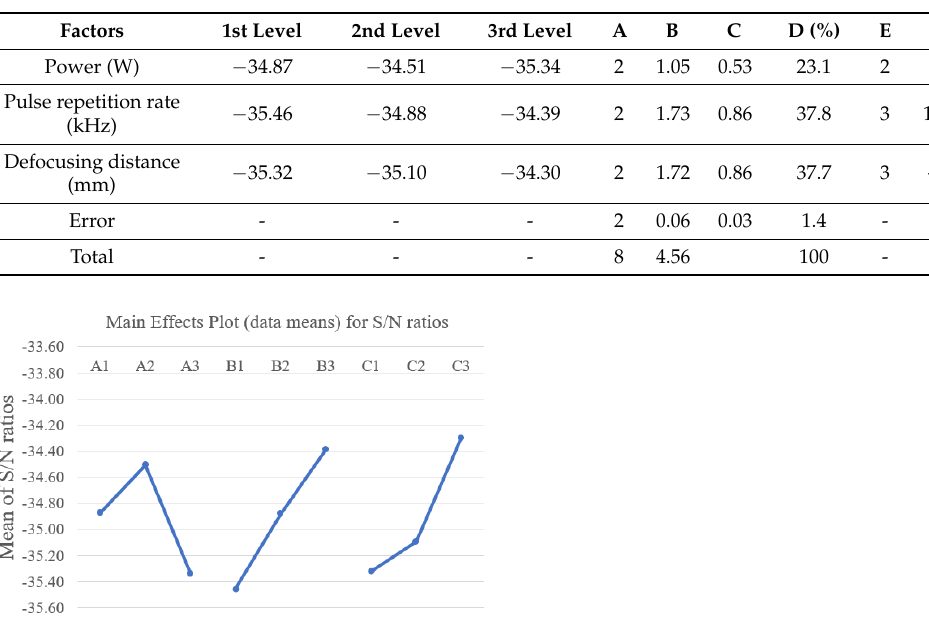
Table 5. For isolation line width, average S/N ratios of factors and levels, ANOVA table according to Taguchi L9 experiment design and comparison of optimum levels and values obtained by Taguchi method. (A) Degree of freedom, (B) Sum of squares (SS T ), (C) Average of sum of squares (variance), (D) Effect of factors (%), (E) Optimum Levels, (F) Optimum Values (theoretical).